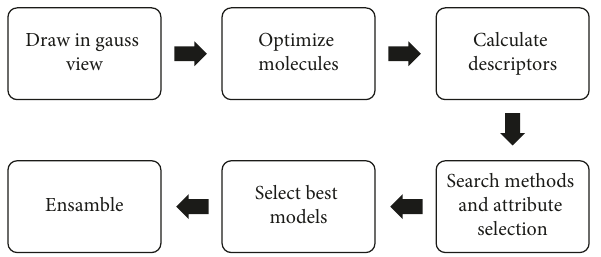
50 values between